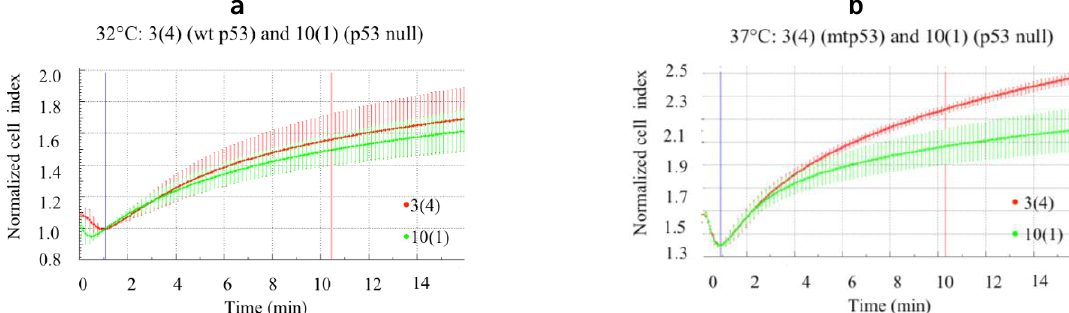
Figure 6. Increase in expression of GOF mtp53 was associated with increased deformability. Change in cell impedance (expressed as normalized cell index) in isogenic p53 null cell line 10(1) or in the cell line 3(4) expressing ts p53 is shown. Cell lines were cultured at 32 °C for wtp53 conformation or at 37 °C to induce the mtp53 conformation in the 3(4) cell line, as described elsewhere [20]. ( a ) The normalized cell index ( i.e. , change in impedance) of 10(1) (green) and 3(4) (red) cells cultured at 32 °C were recorded to